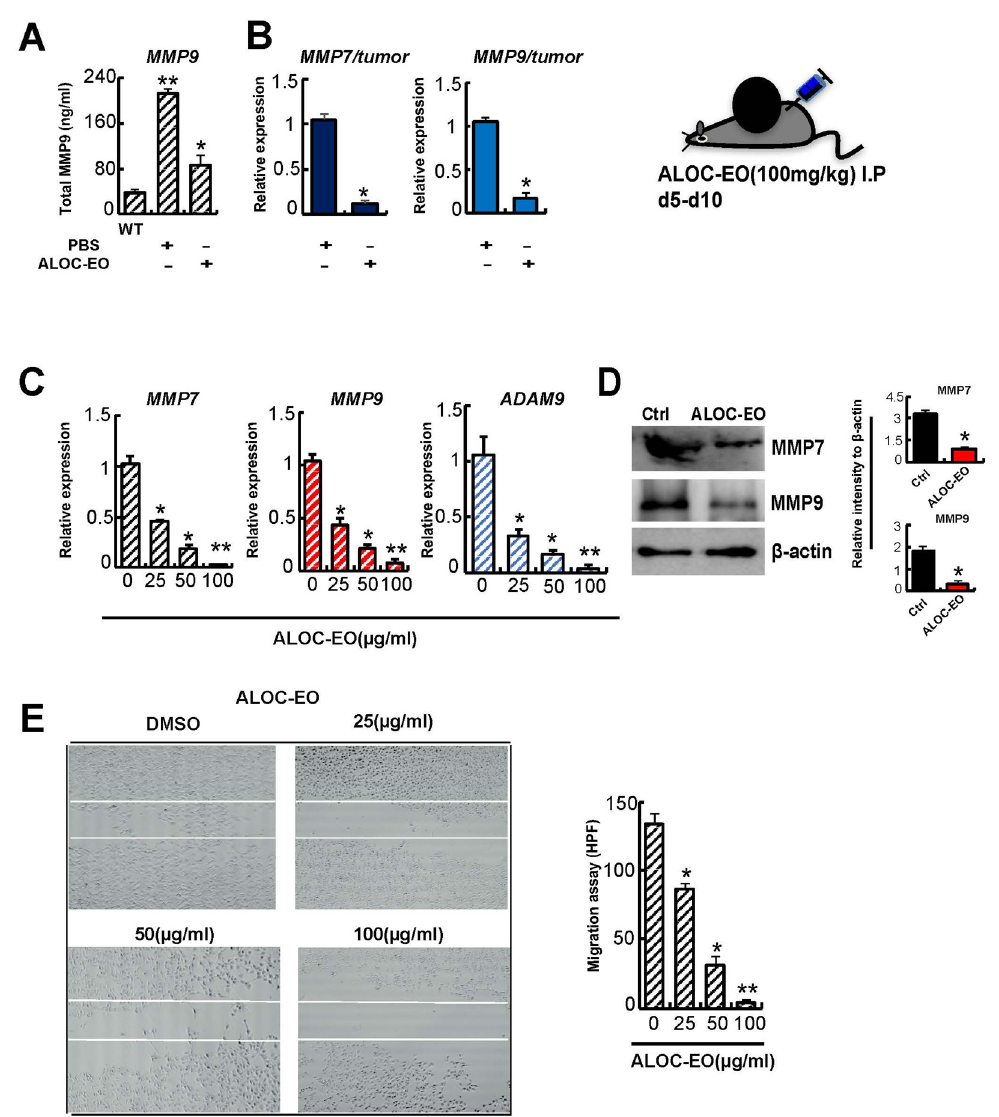
Figure 2. ALOC-EO blocks melanoma cell migration and MMP expression. ( A ) MMP9 levels in the plasma of B16F10-tumor-bearing mice injected with/without ALOC-EO starting from day 5 (n = 6/group). ( B ) MMP7 and MMP9 expression was determined by qPCR in tumor tissues of ALOC-EO treated and untreated mice. ( C ) MMP7 , MMP9 , and ADAM9 expression were determined by qPCR in B16F10 cells cultured for 24 h with indicated concentrations of ALOC-EO. ( B , C ) Transcript levels were normalized to β -actin. Graphs represent averages from three to seven independently prepared templates. The data represent two independent experiments with similar results. ( D ) Western blot analysis of MMP7, MMP9, and the loading control β -actin in B16F10 cells treated with DMSO (control) or ALOC-EO. Right panel: The histograms represent the signal intensity of the indicated protein bands in arbitrary units after normalization with the signal intensity of β -actin internal control for each sample. Values are means and SEM of two independent experiments. ( E ) Faster wound closure in B16F10 cultures supplemented with DMSO or ALOC-EO (left panel). The migrated cells in the scraped area (right panel) were counted per high power fields (HPF). A total of six HPF per condition were evaluated. Data are mean +/ − SEM. * p < 0.05; ** p < 0.01 (Student’s t -test).